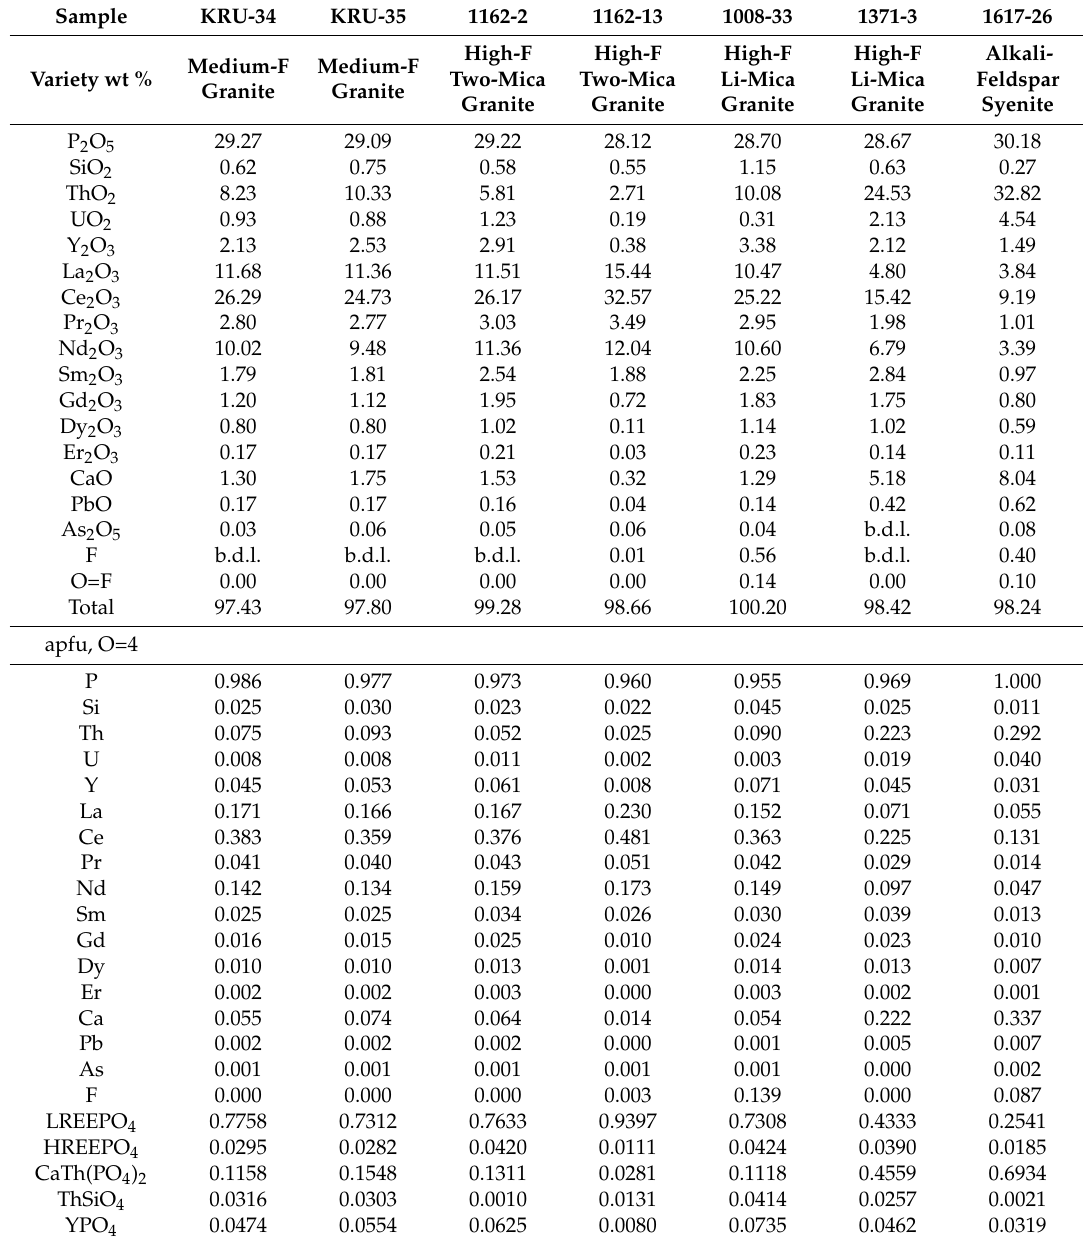
Table 2. Representative EPMA of